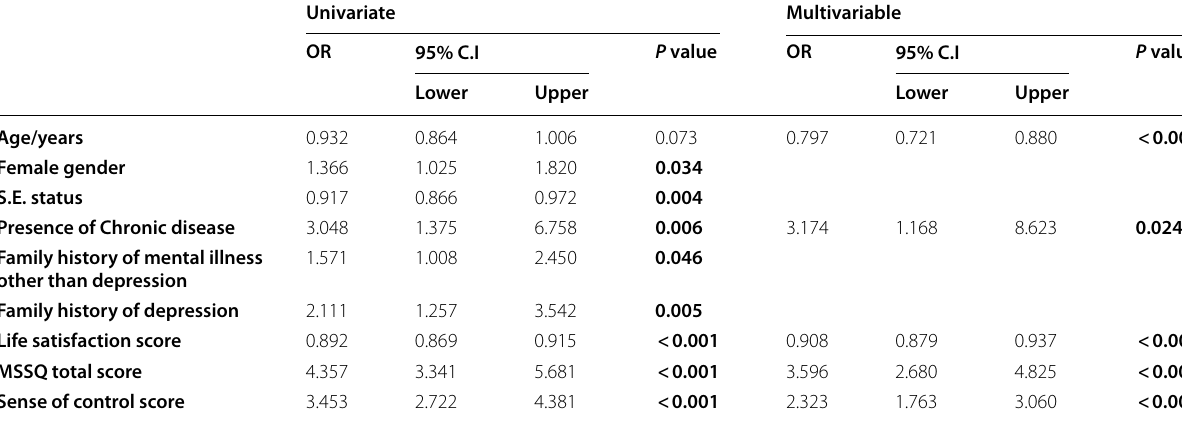
OR odds ratio and CI confidence interval. Model used was backward LR